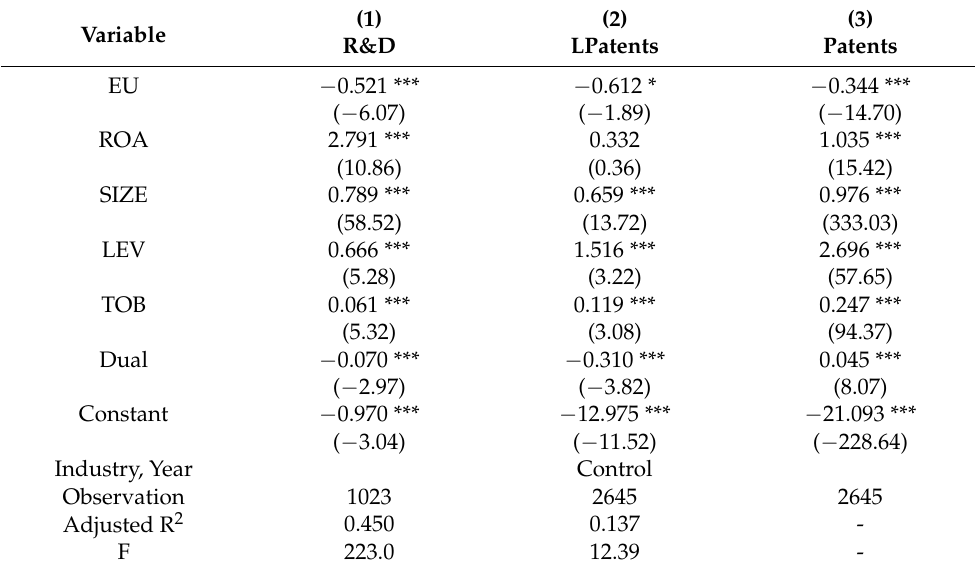
Table 3. Regression analysis of environmental uncertainty and enterprise technological